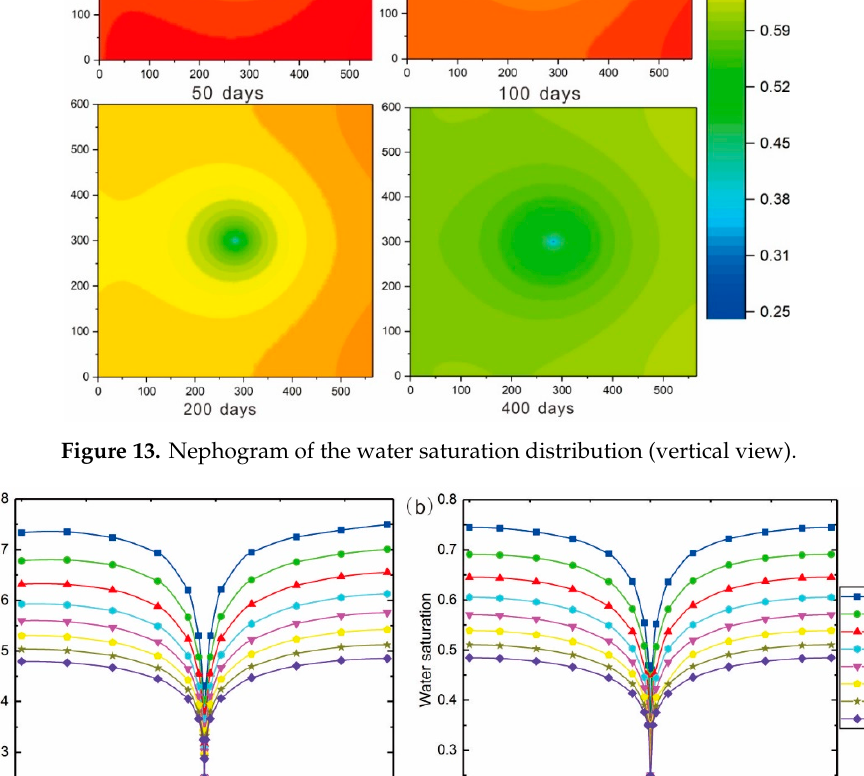
Figure 15. Evolution of water saturation at the three couples of points along the dip.